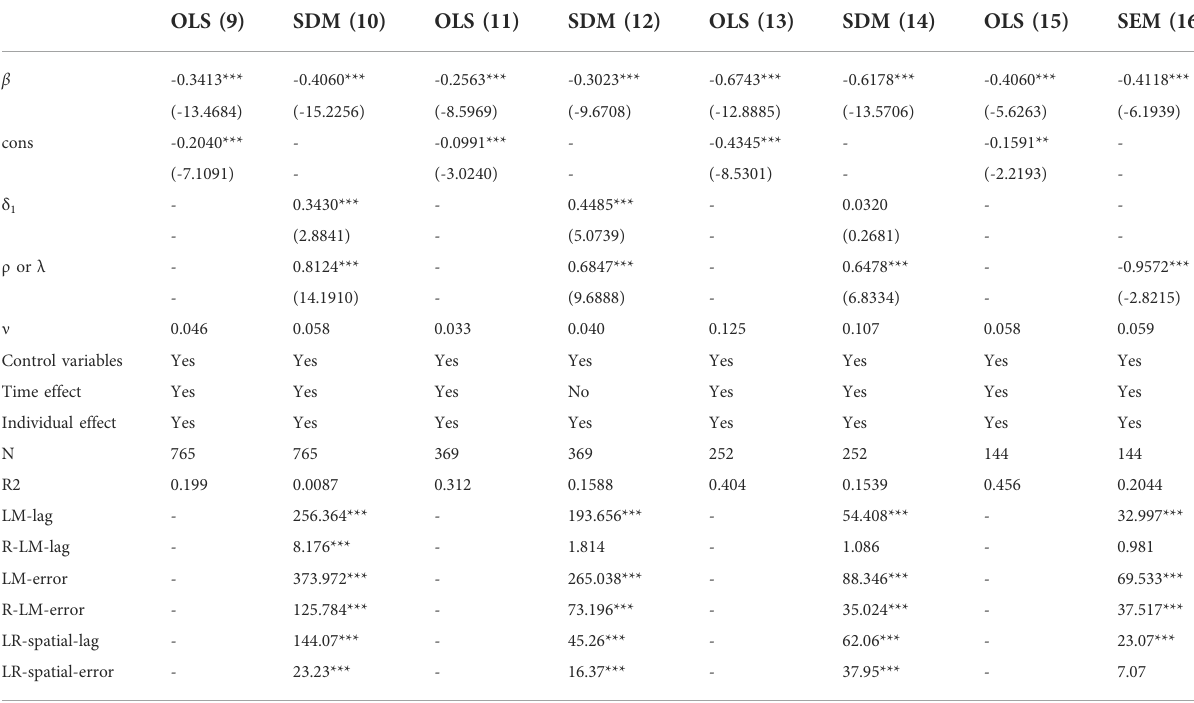
TABLE 7 Results of the conditional β convergence analysis.